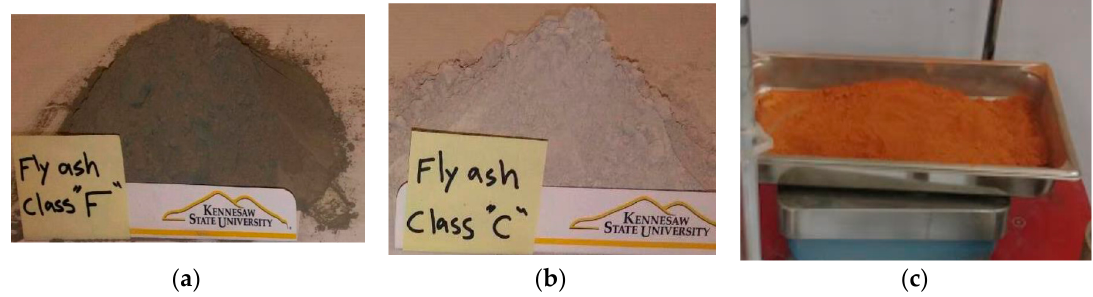
Figure 1. Appearance of typical ( a ) Class F fly ash and ( b ) Class C fly ash and ( c ) soil used in this study .